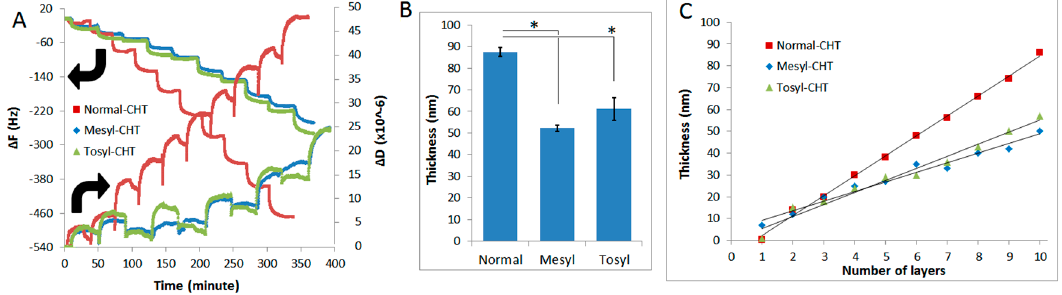
Figure 2. Representative quartz microbalance with dissipation monitoring (QCM-D) acquisition graphics depicting 5th overtone variations of frequency (descending curves) and dissipation (ascending curves) during construction of the multilayered films using normal–CHT/alginate (ALG) (normal), mesyl–CHT/ALG (mesyl) and tosyl–CHT/ALG (tosyl) ( A ); Thickness of films after buildup of 5 bilayers was estimated using Voigt-based viscoelastic model (Average ± SD; * p < 0.05) ( B ); Representative cumulative thickness evolution of the multilayer films as a function of the number of deposition layers. Lines represent linear trend lines with R 2 = 0.99 (normal-CHT), R 2 = 0.97 (tosyl–CHT) and R 2 = 0.97 (mesyl–CHT) ( C ).